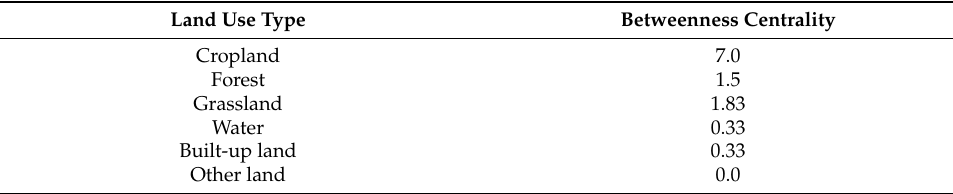
Table 10. Betweenness Centrality of the land use change from 2000–2015.